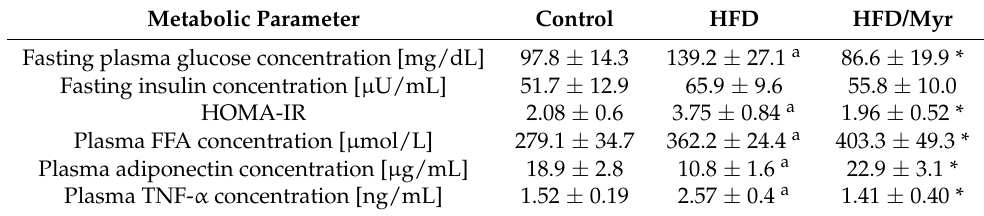
a —vs. Control; *—vs.